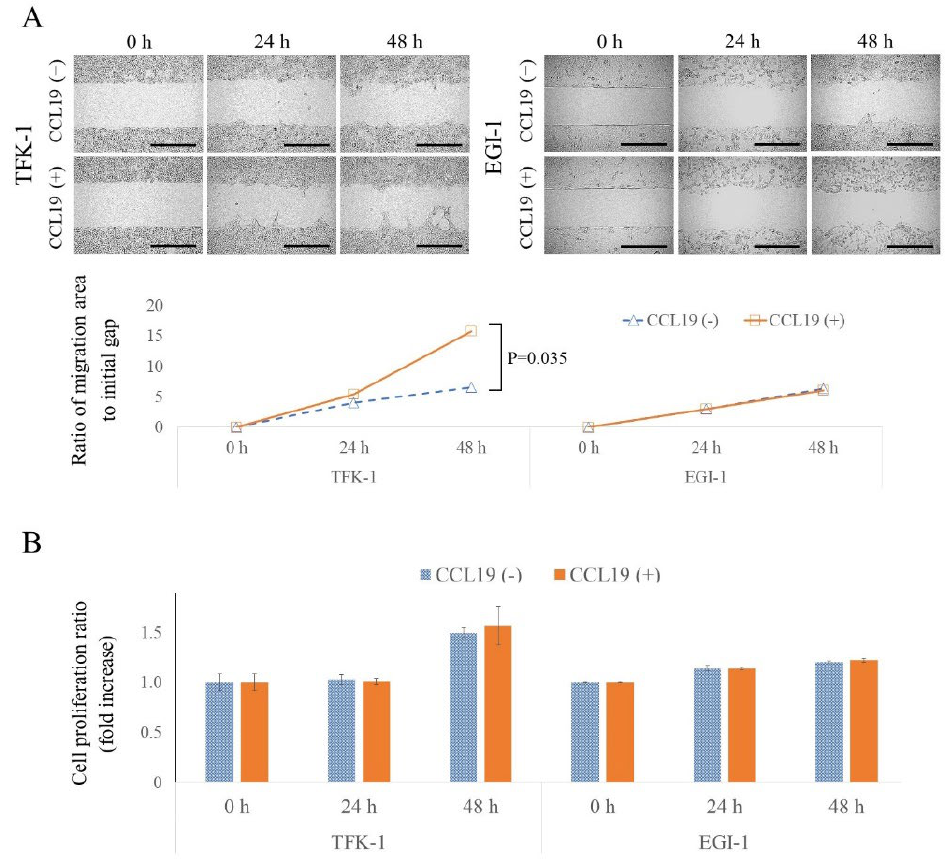
Figure 4. Effect of CCL19/CCR7 on migration and cell proliferation. ( A ) A wound healing assay was used to determine lateral migration ability with or without CCL19 (100 ng/mL) for 24 and 48 h. Migration was significantly enhanced by treatment with CCL19 in TFK-1 cells ( p = 0.035, one-way ANOVA). Scale bar = 500 μm. ( B ) Cell proliferation assay showing the effect of CCL19 (100 ng/mL) treatment at 0, 24, and 48 h using the WST-8 method. Absorbance at 450 nm was measured against a reference wavelength of 650 nm. Each bar represents the mean ± SD of three independent experiments.